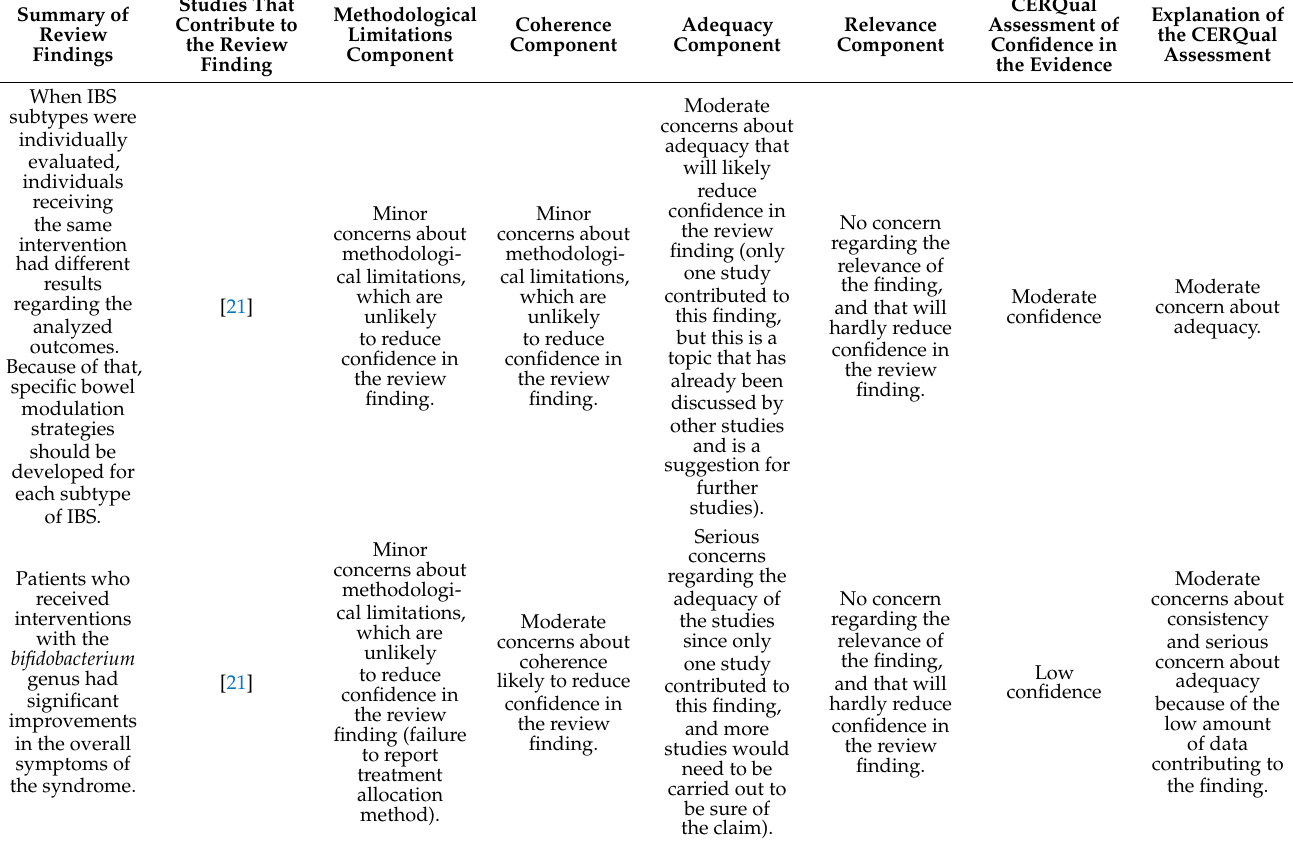
Table A2. CERQual evidence